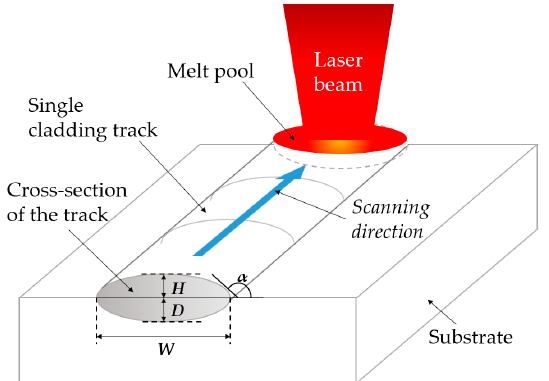
Figure 4. Schematic diagram of a single-cladding track: H is track height, D is track depth, W is track width, and α is cladding angle.